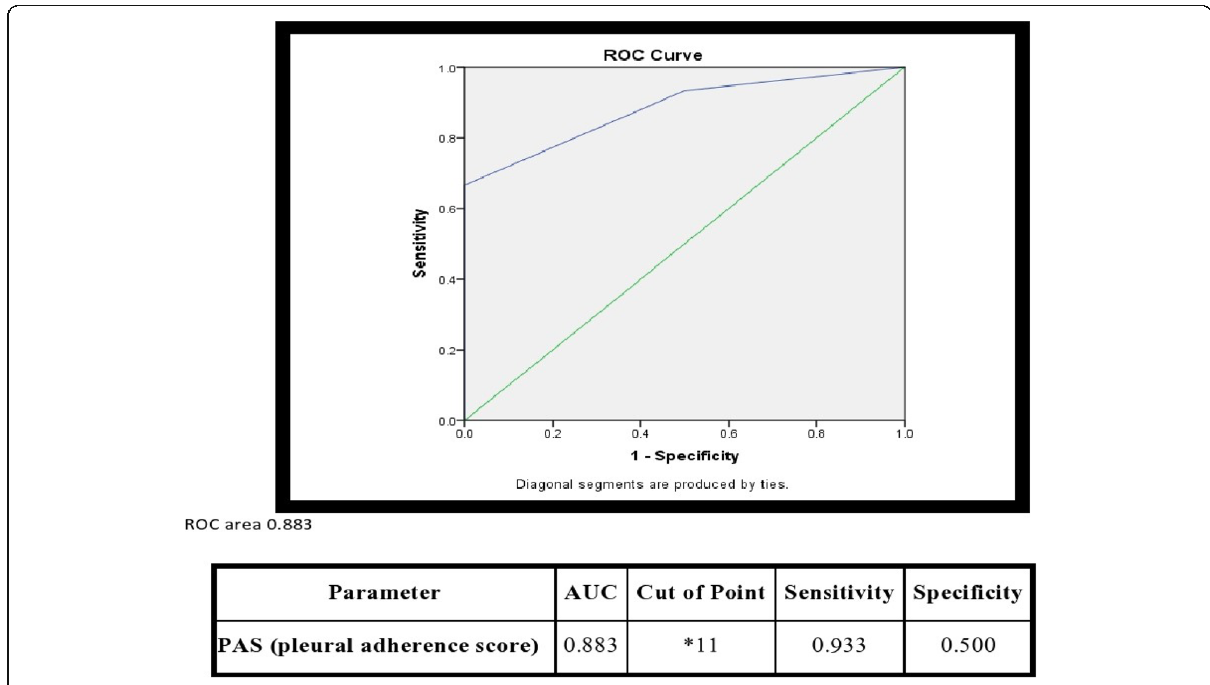
Fig. 2 ROC curve and coordinates for Pleural Adherence Score after 24 h. *The shown number was proposed for detecting pleurodesis success using thoracic ultrasound. ROC, receiver operating characteristic; AUC, area under the